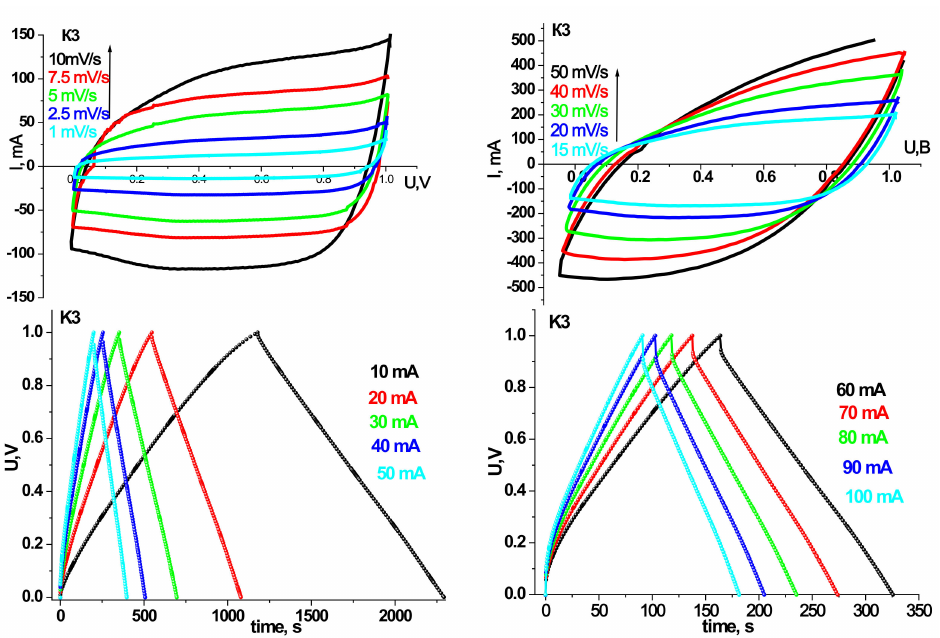
Figure 9. CVA and charge/discharge curves of the layout of HSCs based on the material K3.